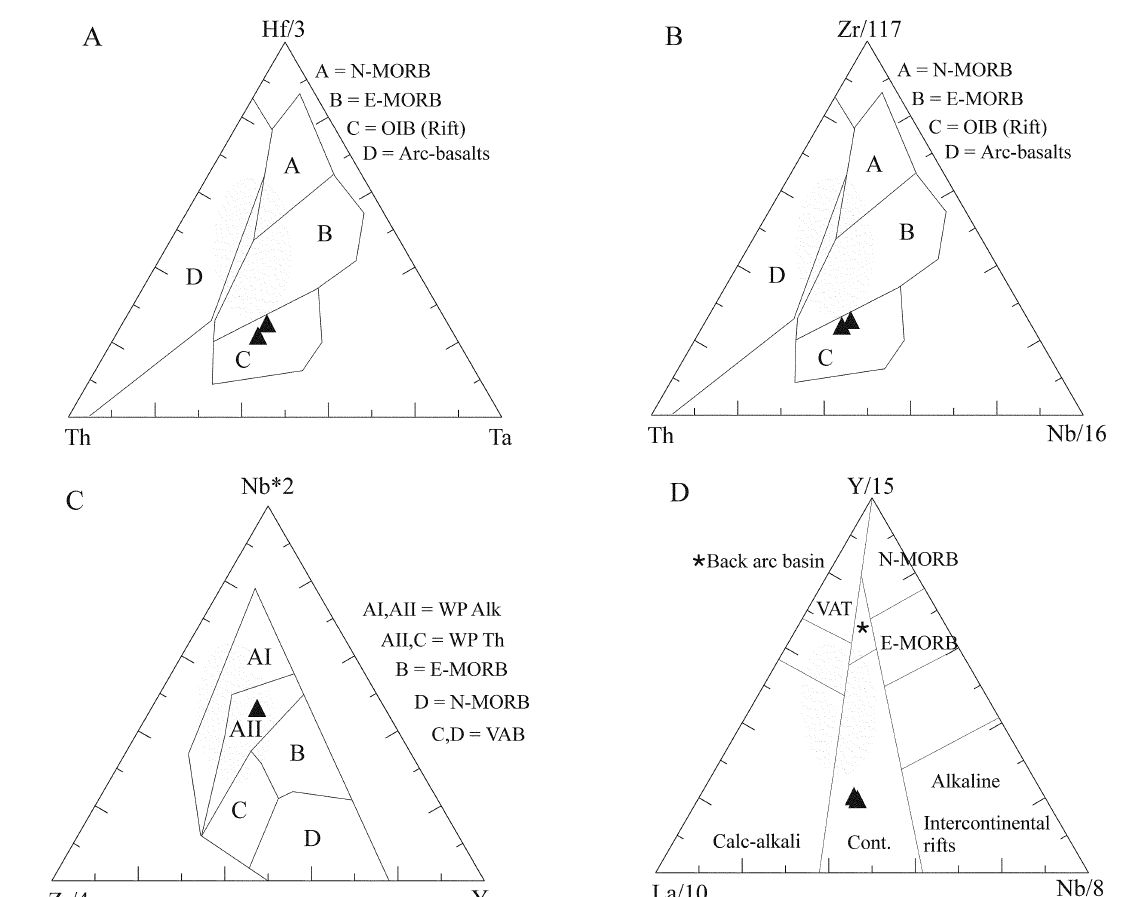
Fig. 8. Tectonic setting diagrams for dolerites from well D1-1: A , Th-Hf/3-Ta; B , Th-Zr/117-Nb/16 (Wood 1980); C , Zr/4-Nbx2-Y (Meschede 1986); D , La/10-Y/15-Nb/8 (Cabanis & Lecolle 1989). E-MORB, enriched mid-ocean ridge basalt; OIB, ocean island basalt; VAB, volcanic arc basalt; VAT, volcanic arc tholeiitic basalt; WP Alk and WP Th, within plate basalt – alkaline and tholeiitic,